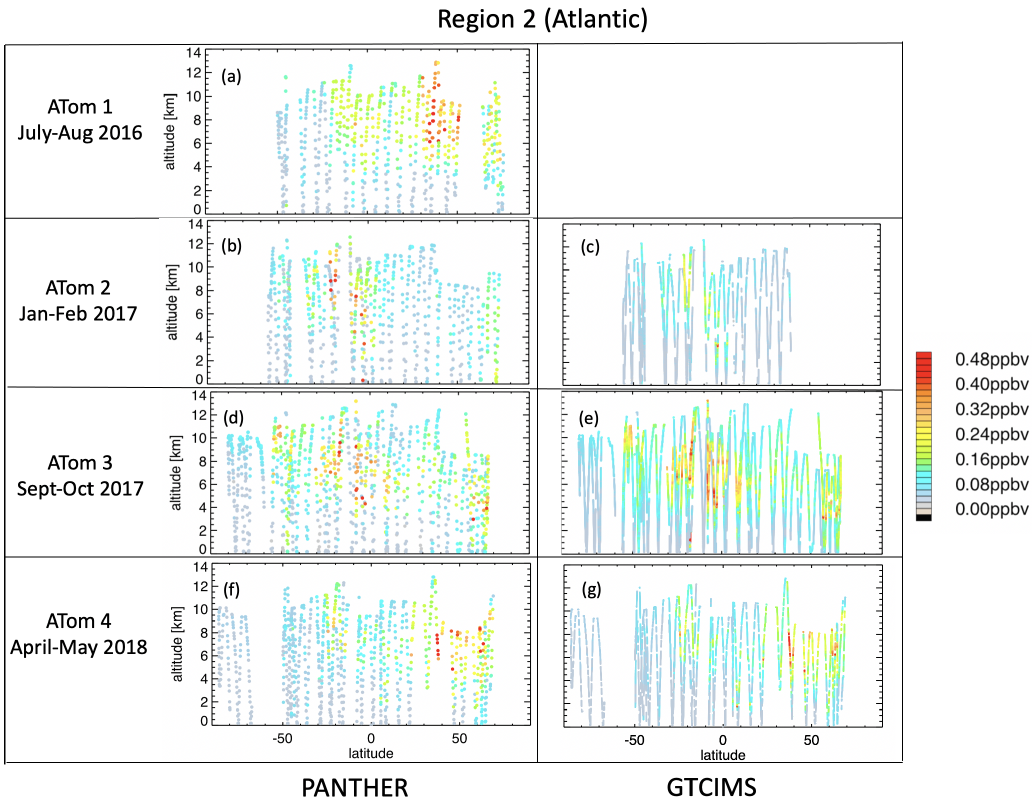
Figure 3. Aircraft measurements of PAN from PANTHER (a, b, d, f) and GTCIMS (c, e, g) instruments from ATom-1, ATom-2, ATom-3 and ATom-4 for Region 1 (Atlantic, longitude greater than − 60 ◦